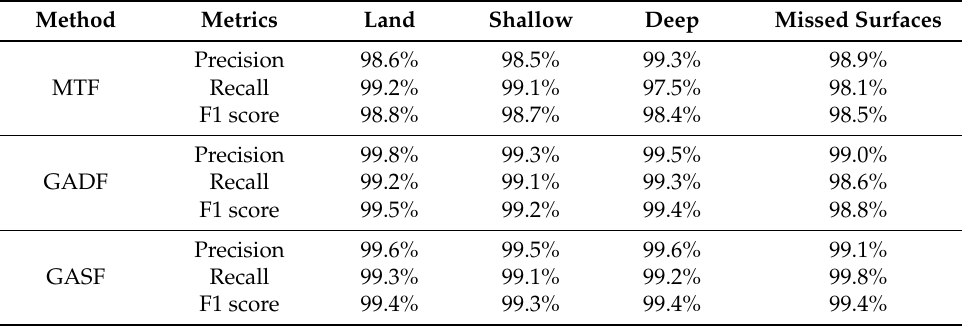
Table 2. Comparison of different methods used on the bathymetry